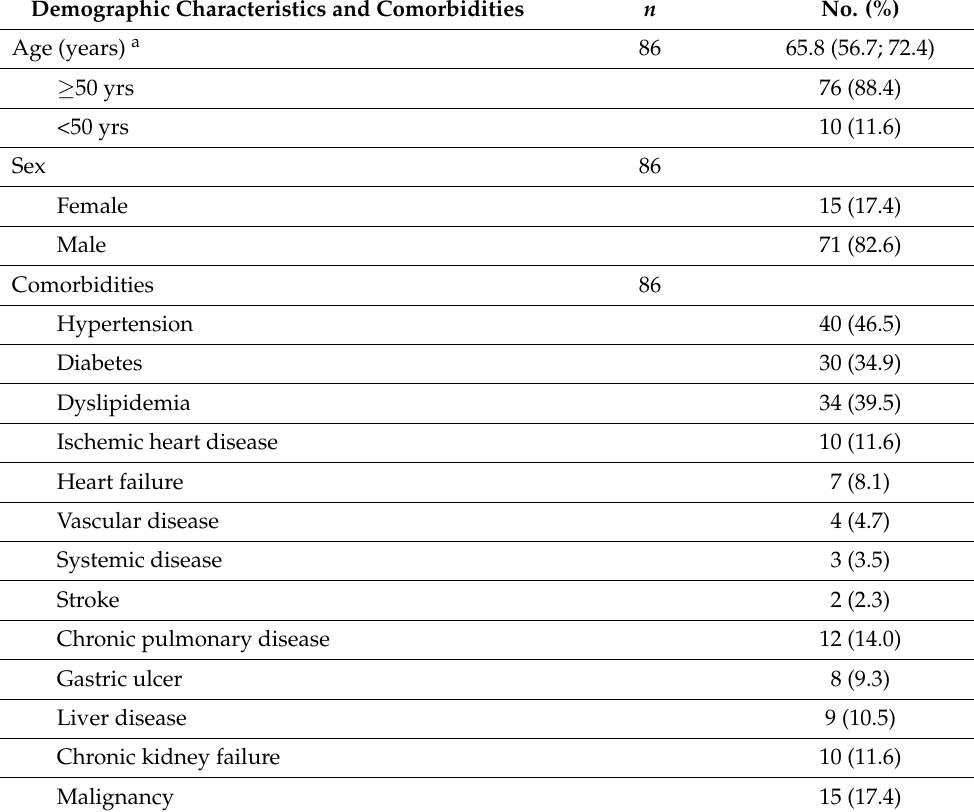
Table 1. Baseline and hospitalization characteristics of the patients.